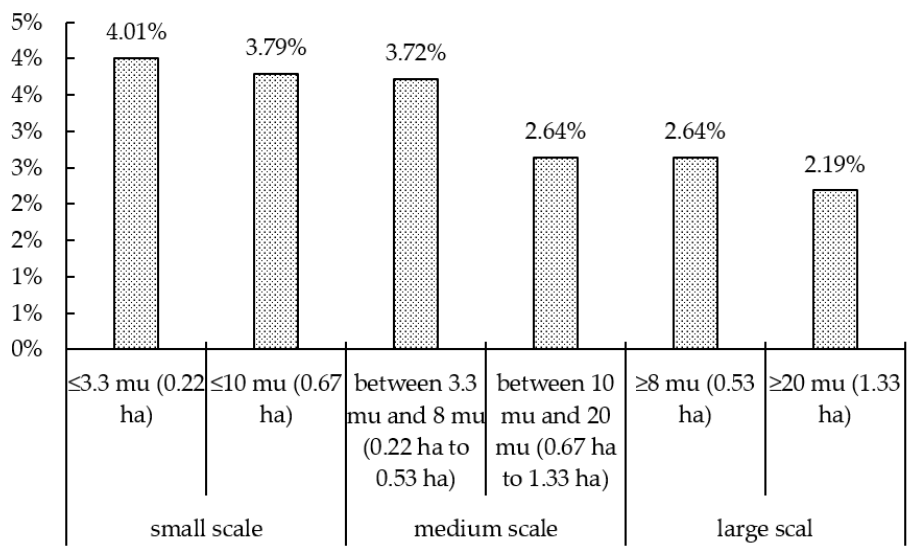
Figure 2. Rice harvest losses for different farm sizes. Note: Small-scale farm: farm size less than 3.3 mu (0.22 ha), 501 households in our database; farm size less than 10 mu (0.67 ha), 1136 households in our database. Medium-scale farm: farm size between 3.3 mu and 8 mu (0.22 ha to 0.53 ha), 512 households in our database; farm size between 10 mu and 20 mu (0.67 ha to 1.33 ha), 233 households in our database. Large-scale farm: farm size larger than 8 mu (0.53 ha), 513 households in our database; farm size larger than 20 mu (1.33 ha), 157 households in our database.